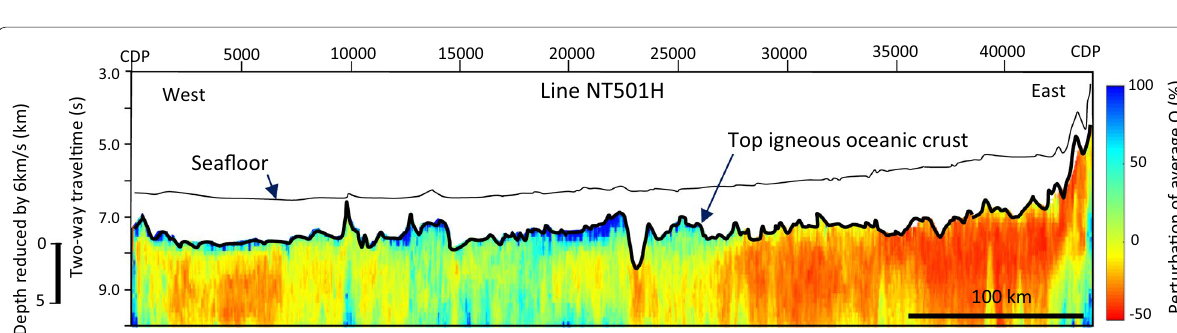
0.6, but still being moderate negative correlation −